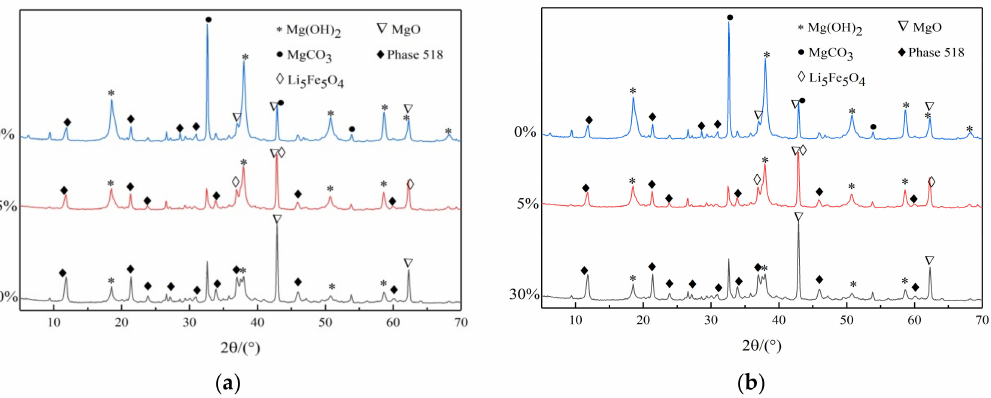
Figure 5. The XRD patterns of MOC with different contents of lithium slag. ( a ) Curing in air and ( b ) Soaking in